Question: What caption would you write for this figure?
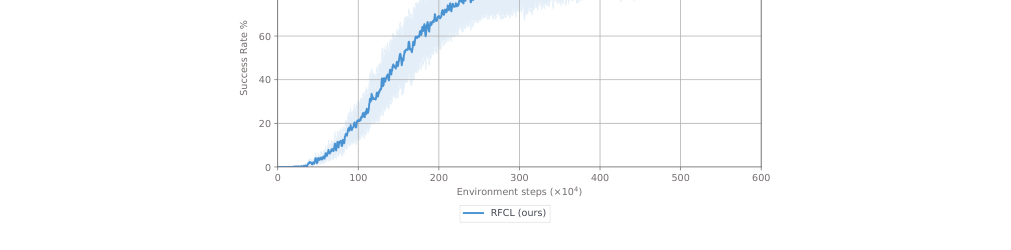
Answer: ManiSkill2 PegInsertion results with random demonstrations. Results averaged over 30 seeds with shaded area representing 95% CIs. The results appear much better than the main figures due to the noise caused by hard-to-learn-from demonstrations being mostly cancelled out. Here, only 1 out of the 30 seeds failed (the same seed from the main results that failed.